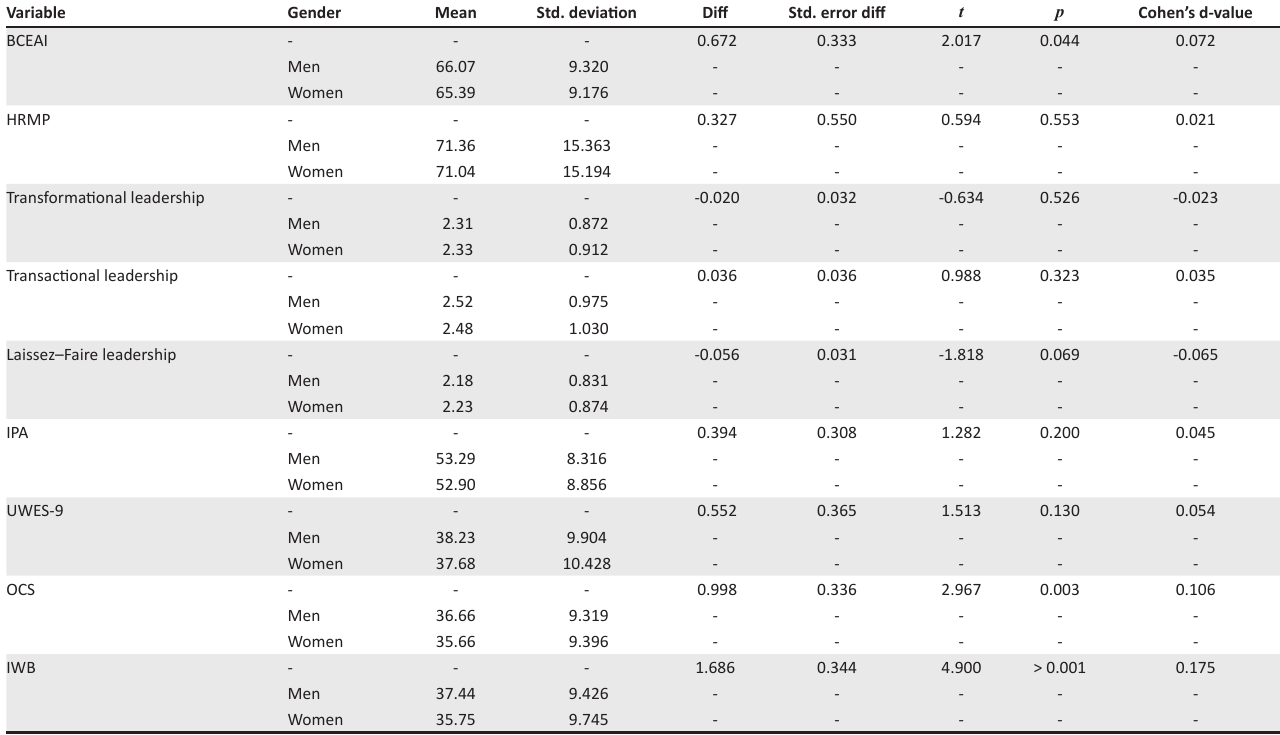
TABLE 2: Descriptive statistics, mean differences and